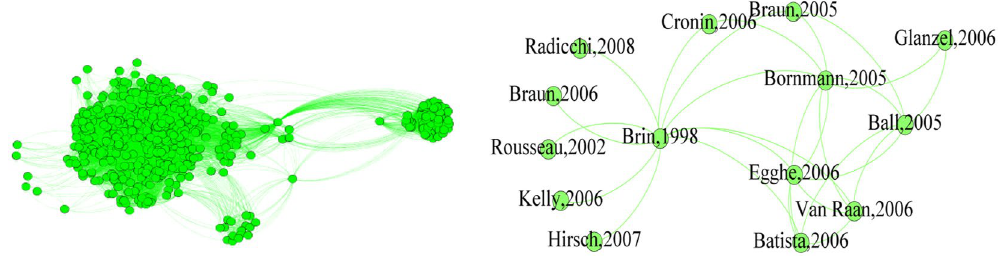
Figure 1. The h -backbone of the co-citation